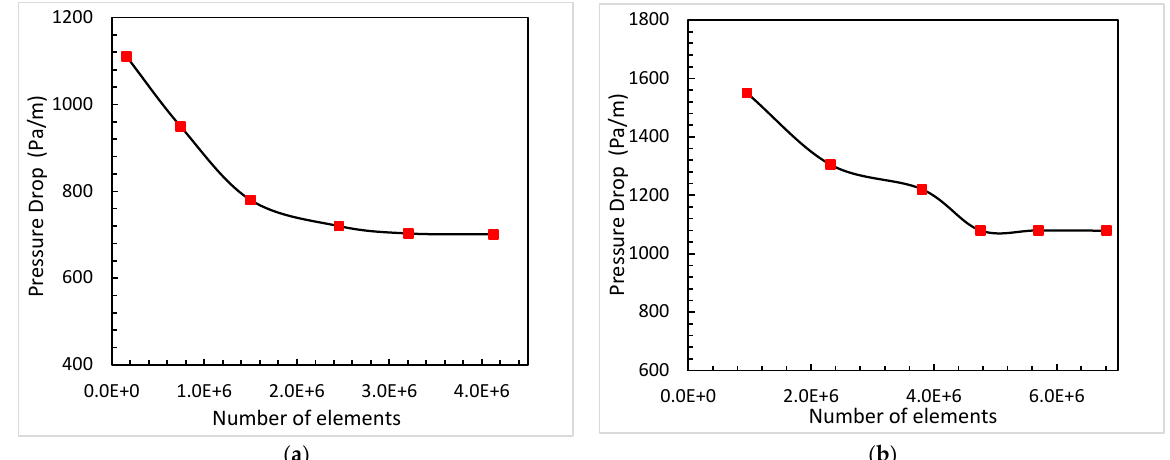
Figure 6. Grid independence study for Newtonian and shear-thinning fluids. ( a ) Water in pipe diameter 76.2 mm for k- ω models. ( b ) BXG4 (Herschel–Bulkley fluid) in pipe diameter 76.2 mm for k- ω models.